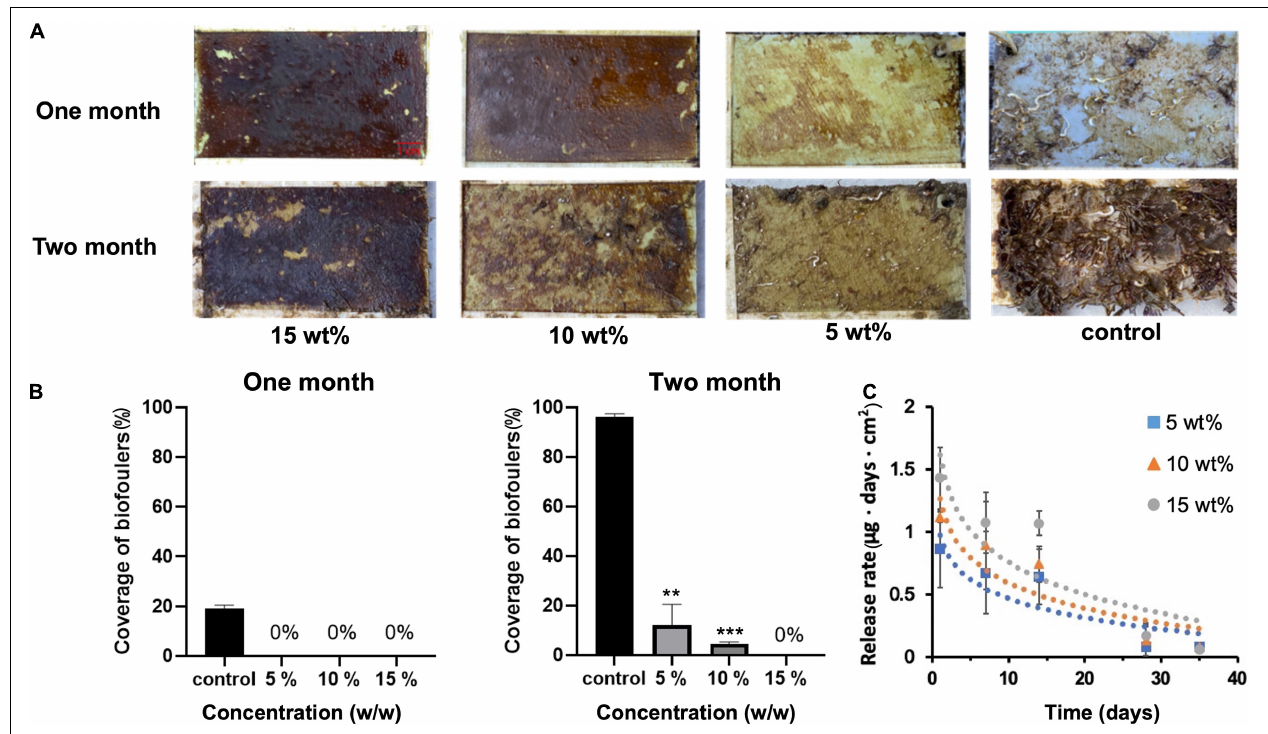
FIGURE 5 | Antifouling effect of albofungin-based copolymer coating in the field test after 2 months. (A) The copolymer was coated with 5, 10, and 15 wt% albofungin on PVC panels. Control was coated with copolymer only. (B) Percentage of coverage of biofoulers after 1 and 2 months. Error bars represent SD ( n = 3). Significant differences were analyzed by one-way ANOVA, ** p < 0.01, and *** p < 0.001. (C) Time-dependent release rate of albofungin into artificial seawater. Error bars represent SD ( n = 3). Significant differences were analyzed by one-way ANOVA and no significant differences were found between 5, 10, and 15 wt% albofungin-based coating groups on the same